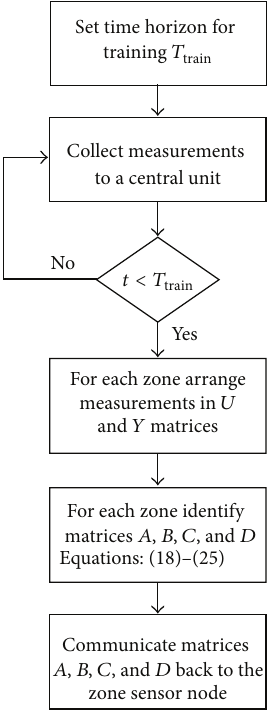
Figure 2: Training phase steps of the